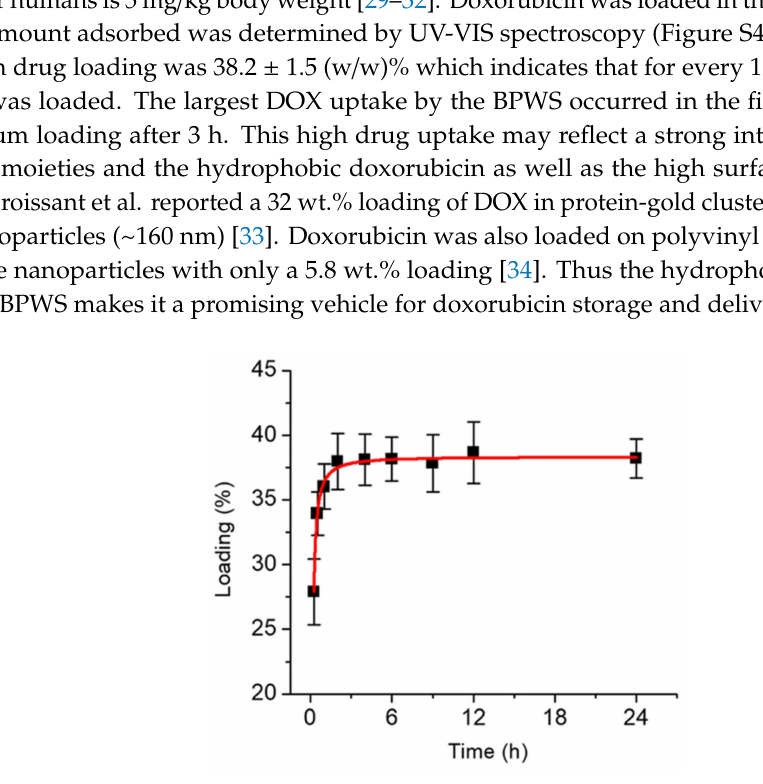
Figure 3. A plot of doxorubicin loading versus time for biphenyl wrinkled mesoporous silica (BPWS)